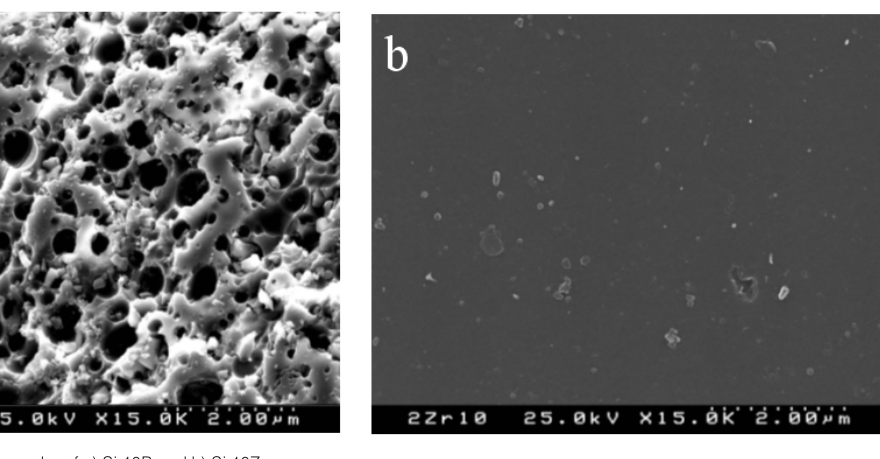
Figure 4. SEM micrographs of a) Si-10B and b) Si-10Zr.